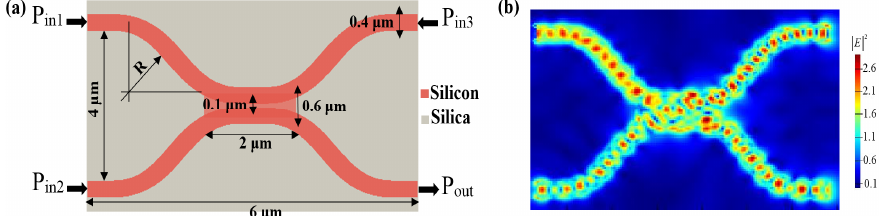
Figure 1. ( a ) Schematic diagram and ( b ) light field distributions of 2 × 2 silicon waveguide. The threshold transmission (T th ) value is initially set to 0.14, which is the